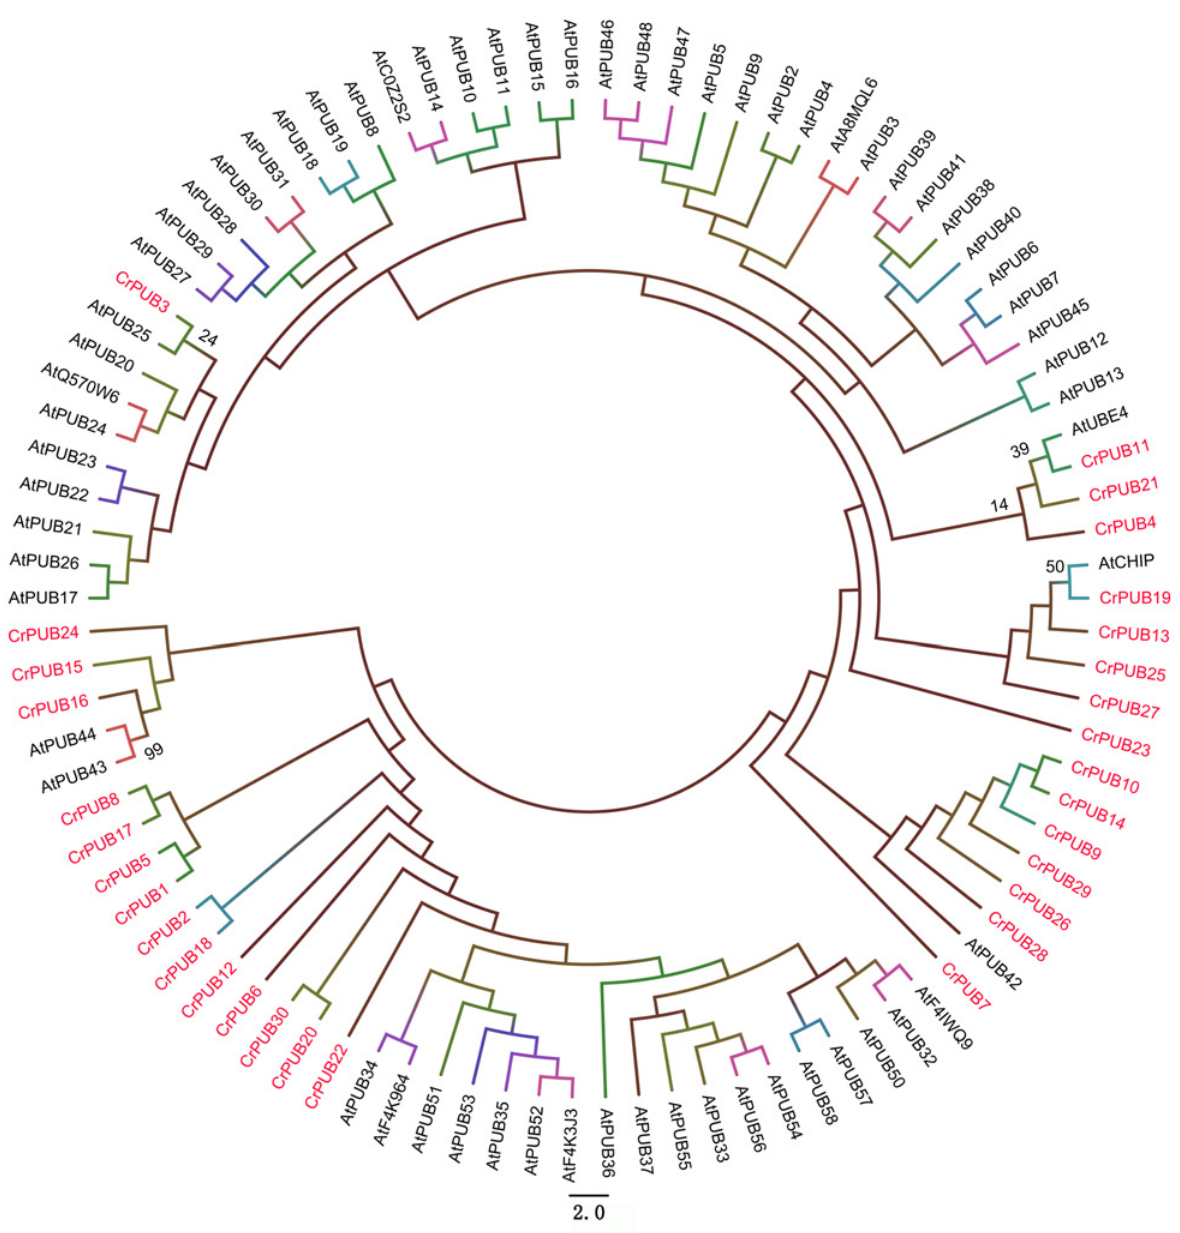
Fig 3. Phylogenetic relationship between C . reinhardtii and Arabidopsis U-box proteins. The amino acid sequences of U-box proteins from the two proteomes were used for analysis. The unrooted tree was inferred using Mega 6.0 software and the neighbor-joining method with 1000 bootstrap replicates. The CrPUB proteins are indicated in pink font; only the Arabidopsis thaliana and C . reinhardtii homologous branches show the bootstrap values as percentages.